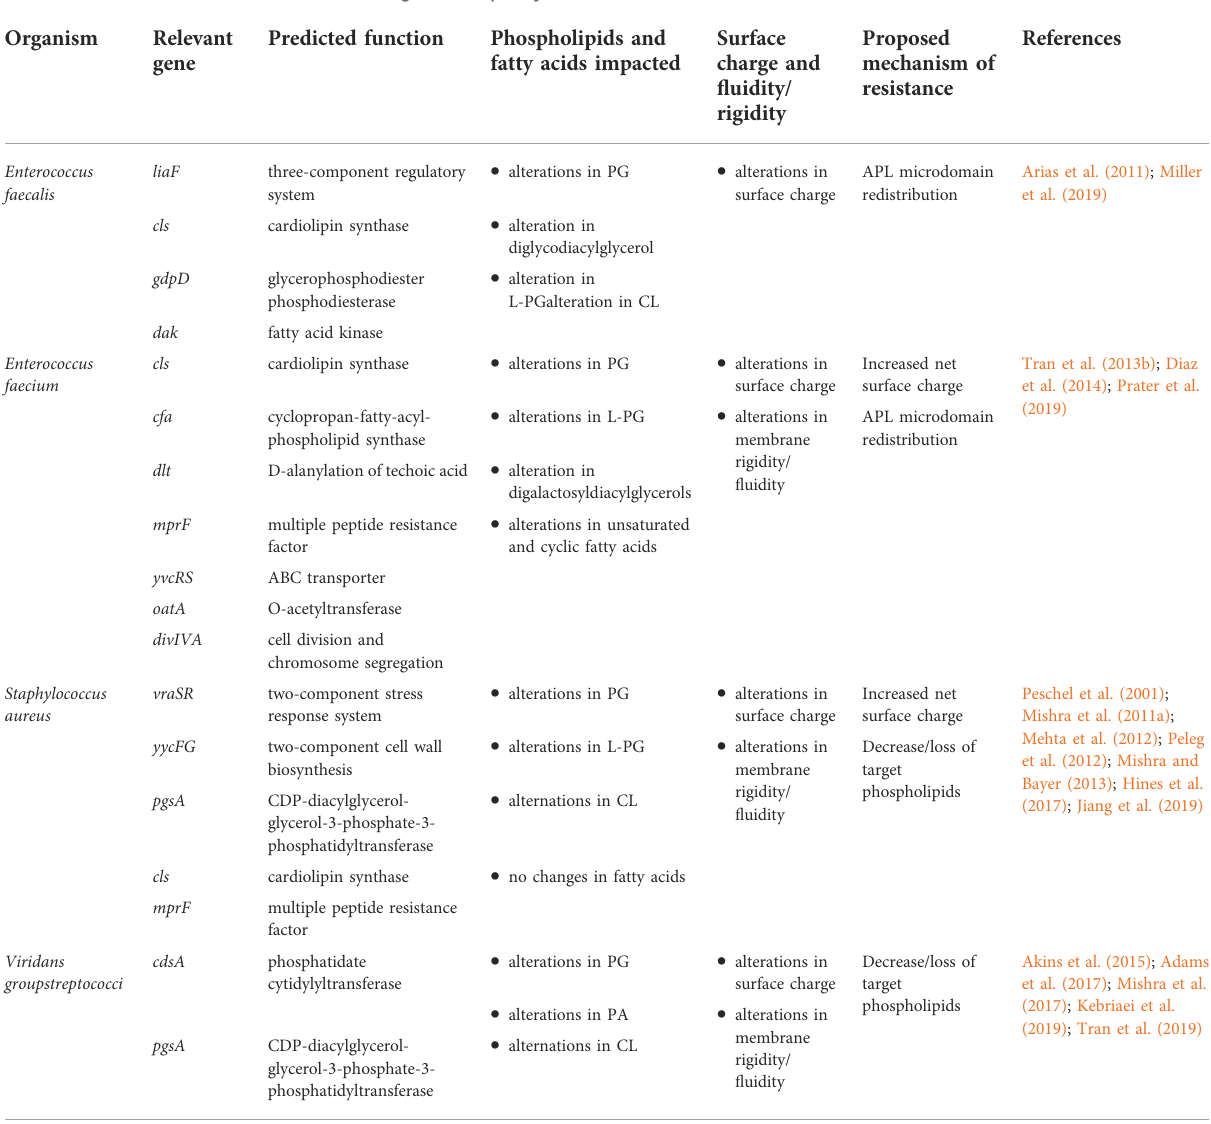
TABLE 1 Genes associated with membrane changes and daptomycin